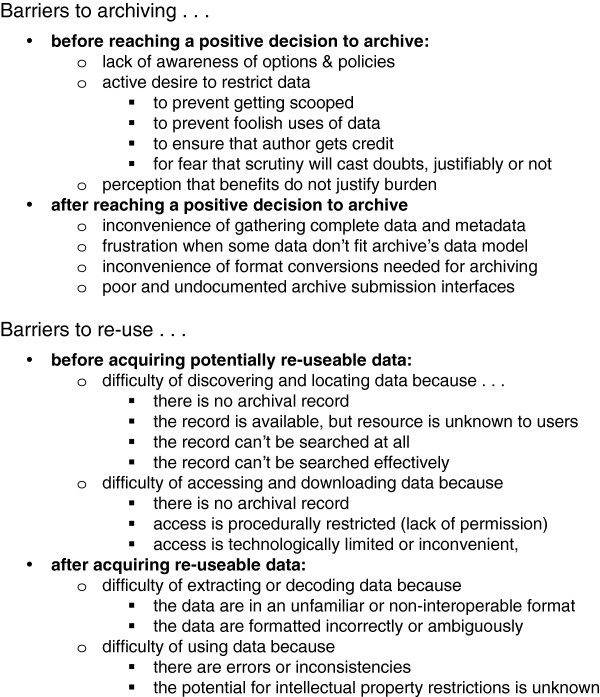
A taxonomy of barriers experienced by users. Barriers may occur at many different steps along the path of re-use. For instance, an author may decide not to archive data, due to the perceived burden. If the author does not archive data, then it is difficult for users to discover that the data exist. Once the user discovers that the data exist by reading a publication, the only way to obtain the data is to write to the author, a process that is known to be subject to delays and refusals. Even if the data are placed in an archive, it may be difficult for users to discover (e.g., journal web sites typically do not offer any kind of content searching for supplementary data) or to access (e.g., users may be required to pay for access). Finally, it is not unusual for archived data to contain errors and ambiguities that make it difficult to apply in scientific research.